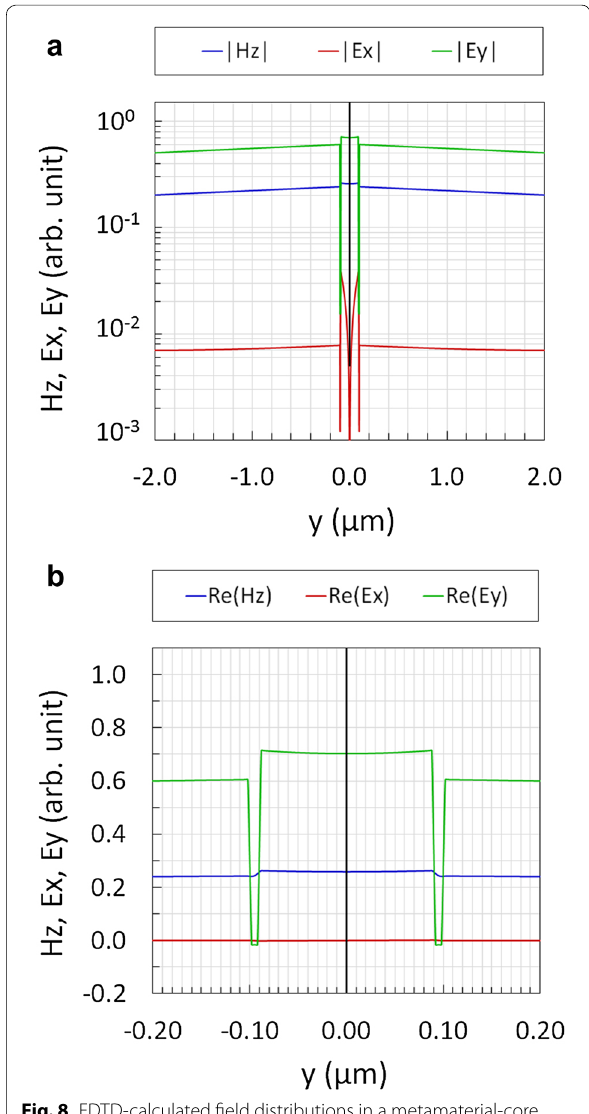
Fig. 8 FDTD-calculated field distributions in a metamaterial-core waveguide structure: soda-lime glass/(10-nm Ag/180-nm SiO 2 /10-nm Ag)/soda-lime glass. a Field amplitude distributions of H z , E x and E y for y in the range of 2 to 2 µm. Note the log scale of field amplitude. − b A close-up view of core layer part (10-nm Ag/180-nm SiO 2 /10-nm Ag). Note that normal E -field (green) takes different signs in metal and dielectric